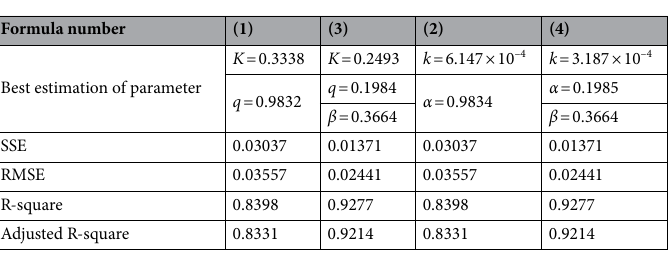
Table 9. Numerical test fitting